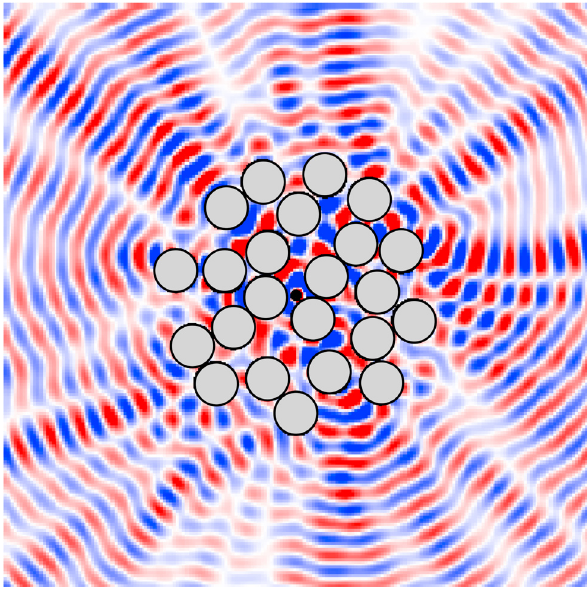
Figure 2: Reflectionless state of a coherent perfect absorber (CPA), consisting of a random aggregate of lossless glass scattering rods (gray) of index n = 1.5 and radius equal to the incident wavelength ( r (cid:1) λ ) , surrounding a highly lossy subwavelength central rod (black) of radius r (cid:1) 0 . 15 λ and dielectric constant ε (cid:1) 1 . 28 + 1 . 75 i .